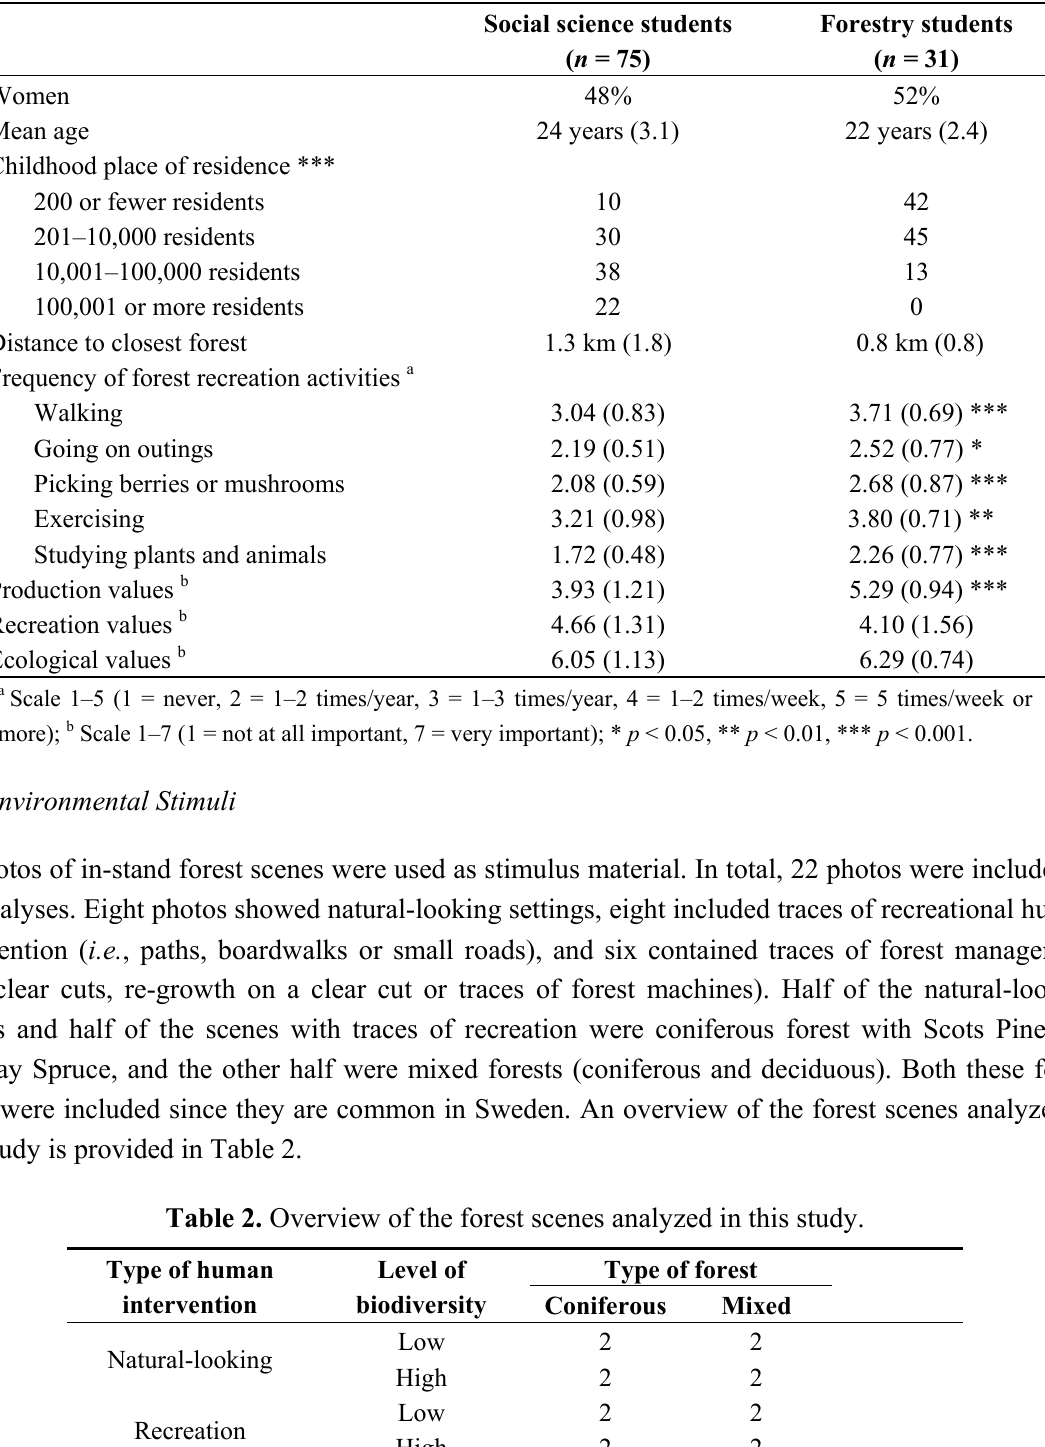
Table 1. Background characteristics.